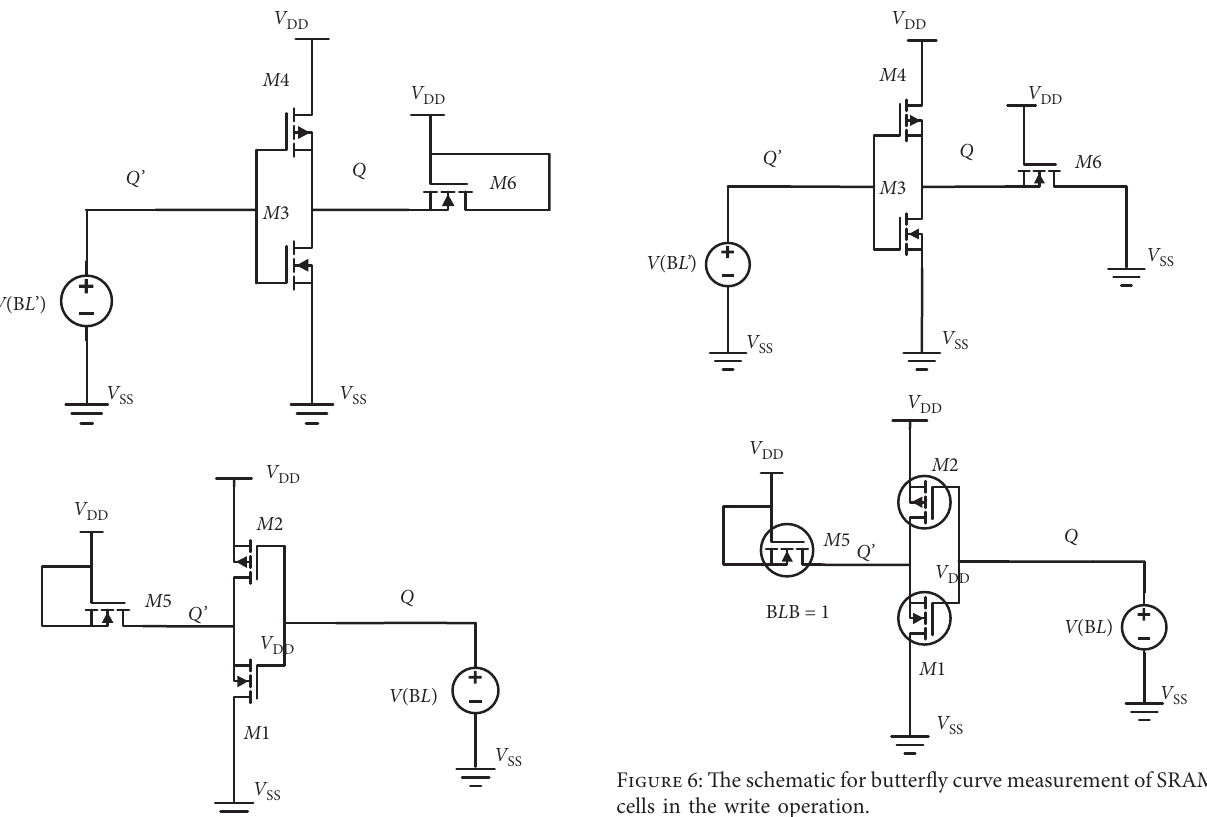
Figure 5: The schematic for butterfly curve measurement of SRAM cells in the access mode.